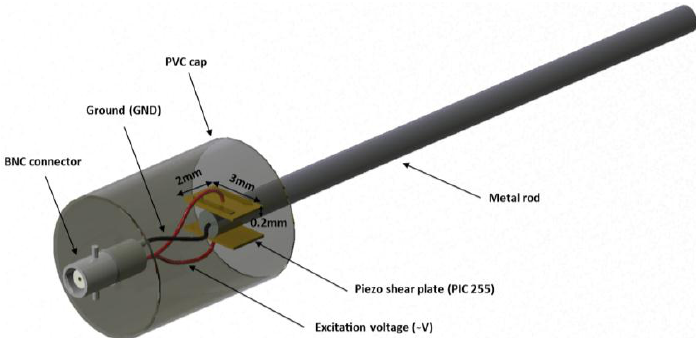
Figure 1. Ultrasonic torsional guided wave viscosity sensor.